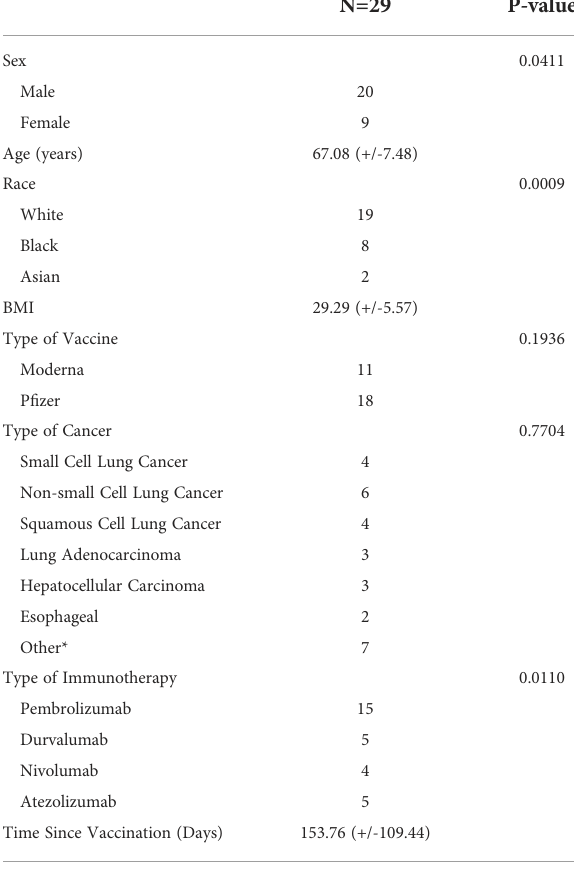
TABLE 1 Description of vaccinated patient